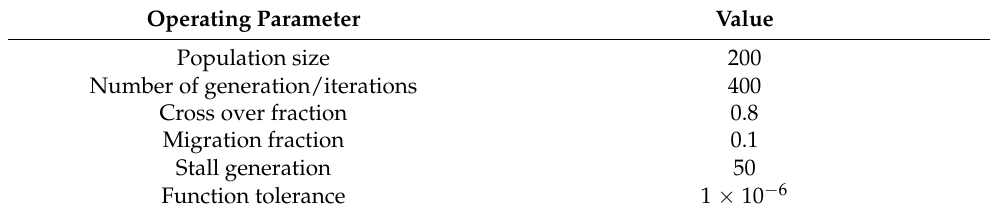
Table 2. Operating values of the